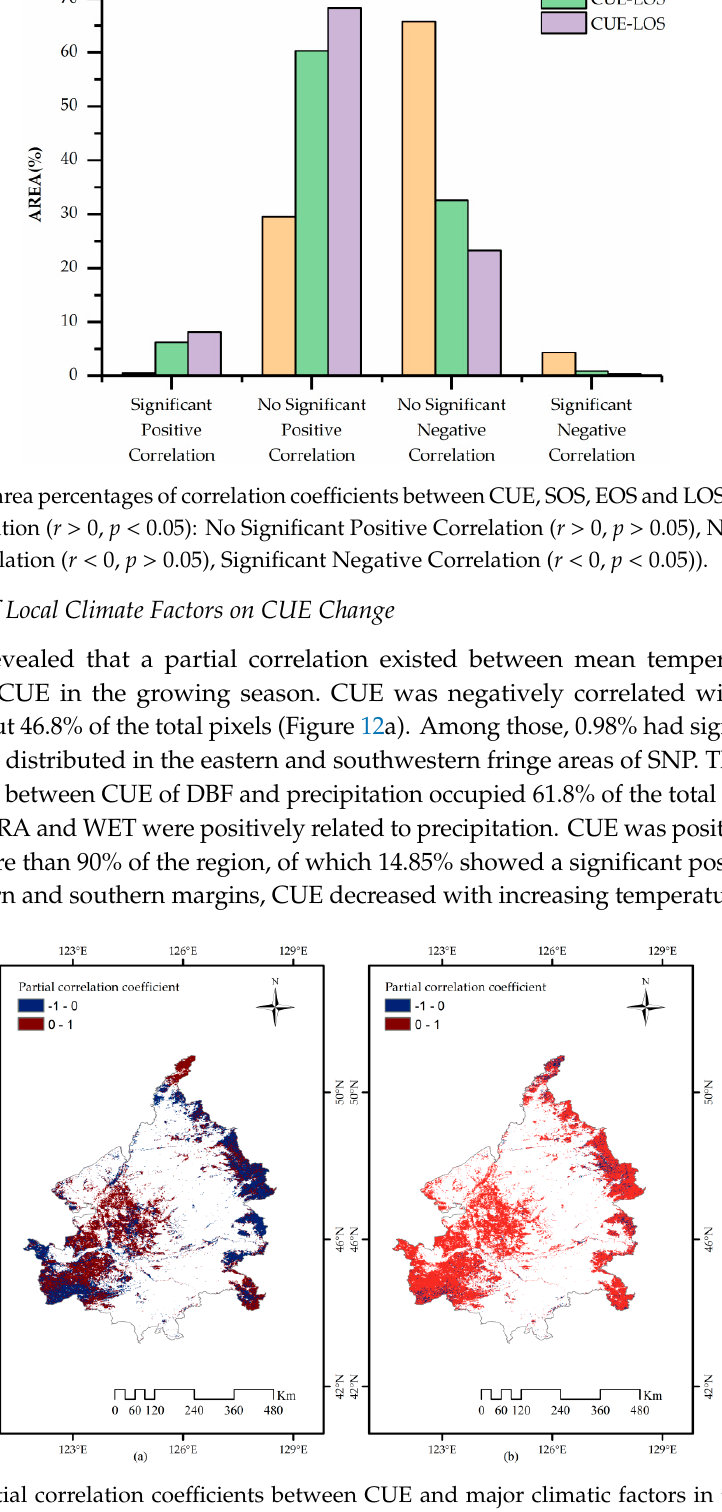
Figure 10. Spatial distribution of correlation coefficients (R) between CUE, SOS, EOS and LOS in the SNP during 2001–2015. ( a ) CUE and SOS; ( b ) CUE and EOS; ( c ) CUE and LOS.